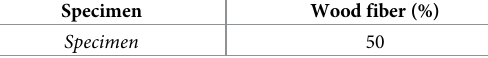
Table 3. Specimen proportioning scheme.